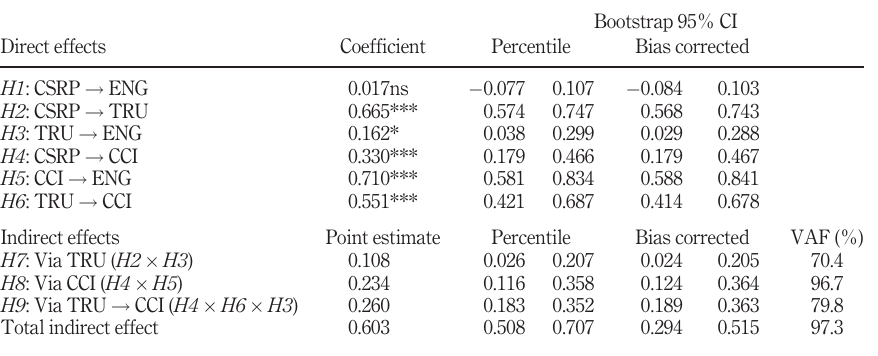
Table VII. Summary